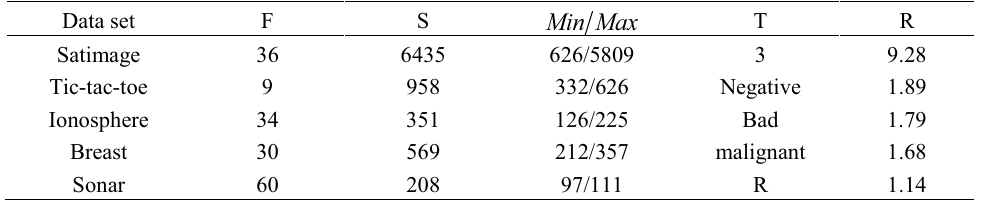
Table 2 Summary of datasets